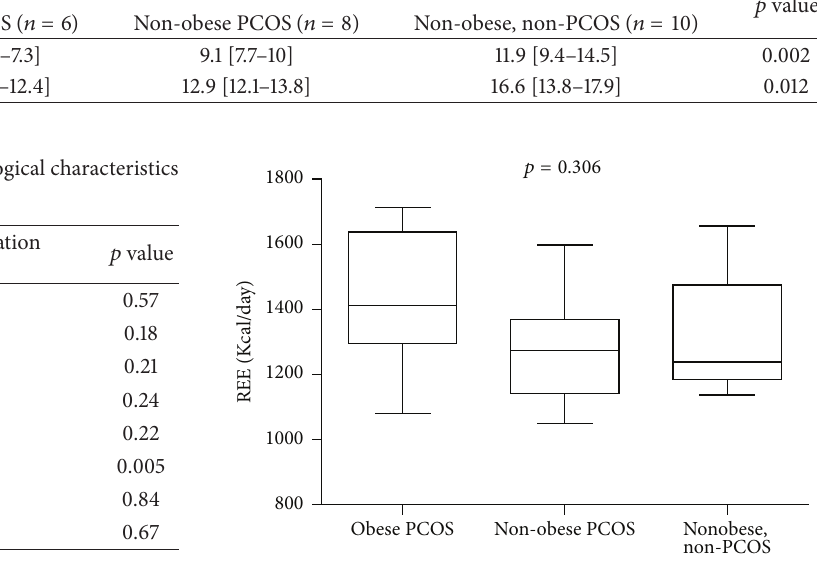
Figure 1: Resting energy expenditure adjusted for total body mass in Kcal/day across subgroups.